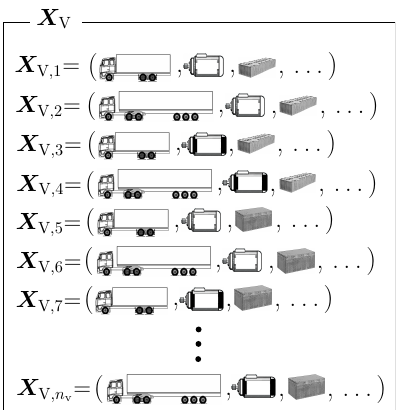
Figure 2. Example of X V —set of n v vehicle types. X V denotes the set of vehicle types and X V, i denotes ith vehicle type.